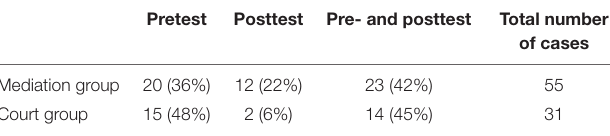
TABLE 1 | Overview of the demographic and case-specific variables of offenders ( N = 86).